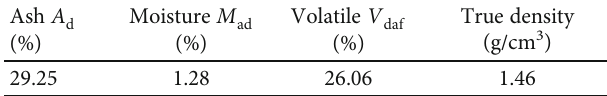
Table 1: Industrial analysis values of experimental coal